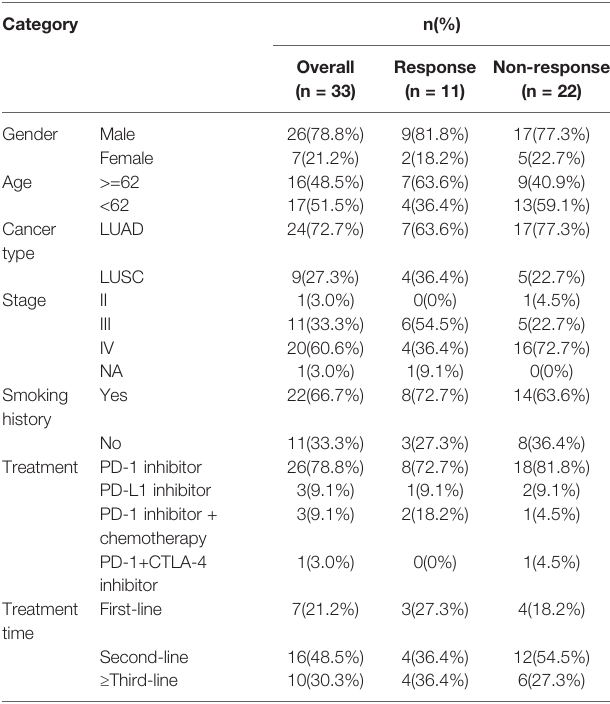
TABLE 1 | Clinical